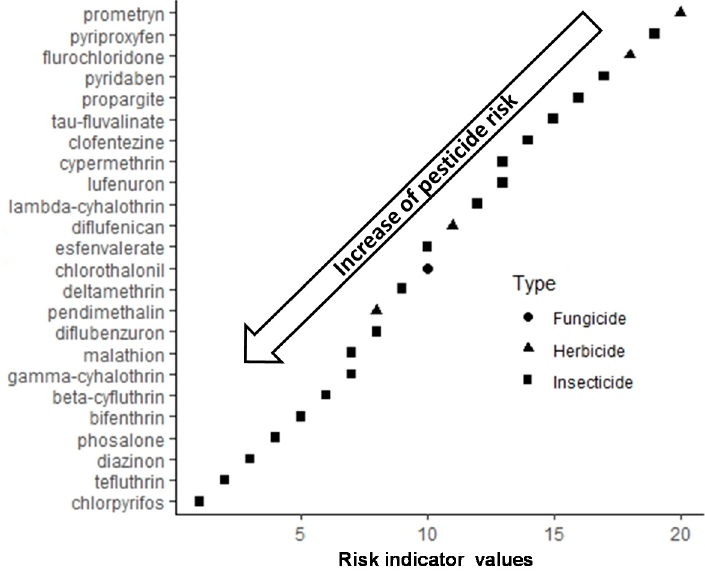
Figure 14. Rating of the pesticide risk indicators for aquatic organisms.